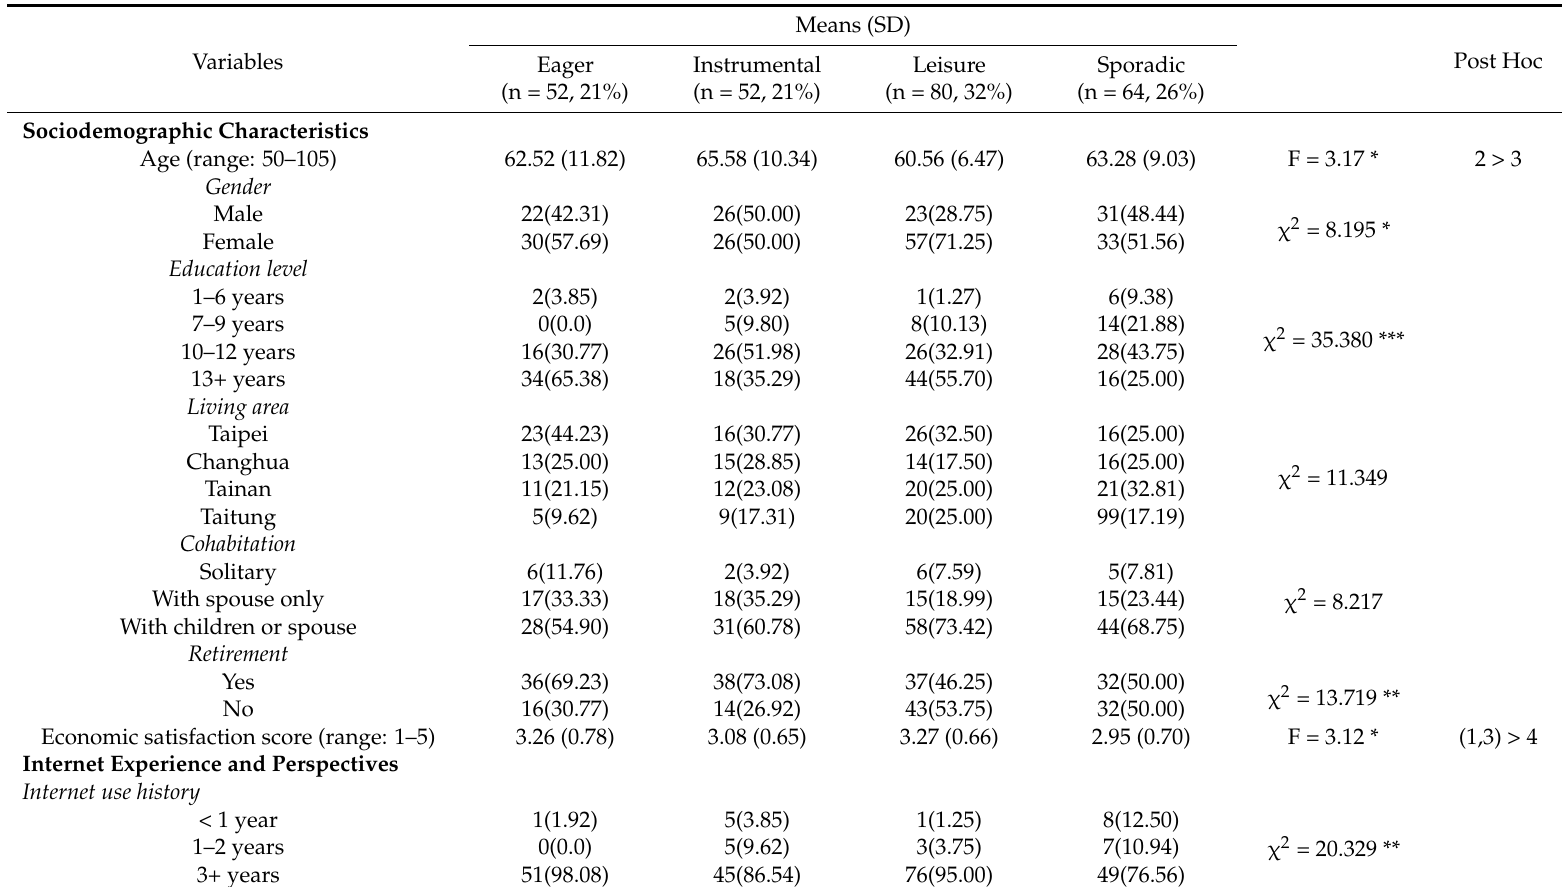
Table 2. Typology of Internet use among middle-aged and older adults and their association with sociodemographic, Internet experience/perspectives, and social engagement